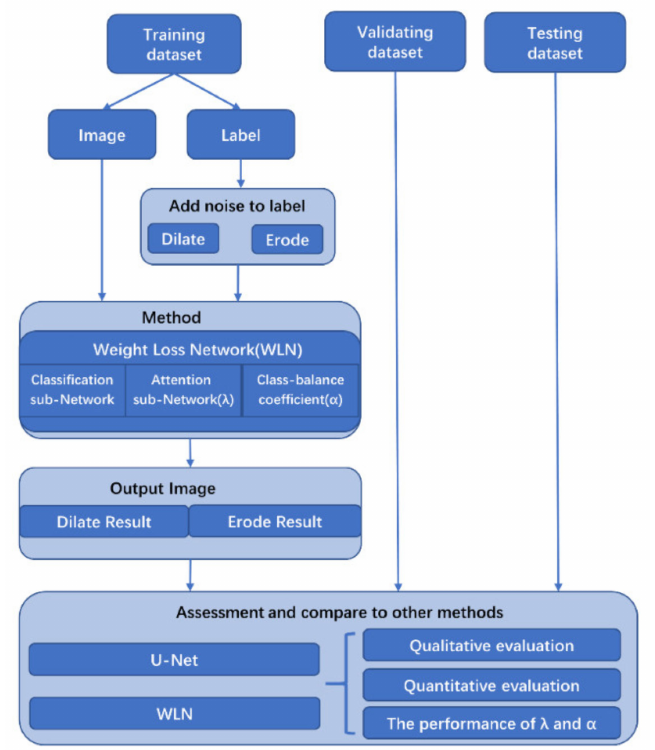
Figure 3. An overview of the workflow of this study. WLN: Weighted Loss